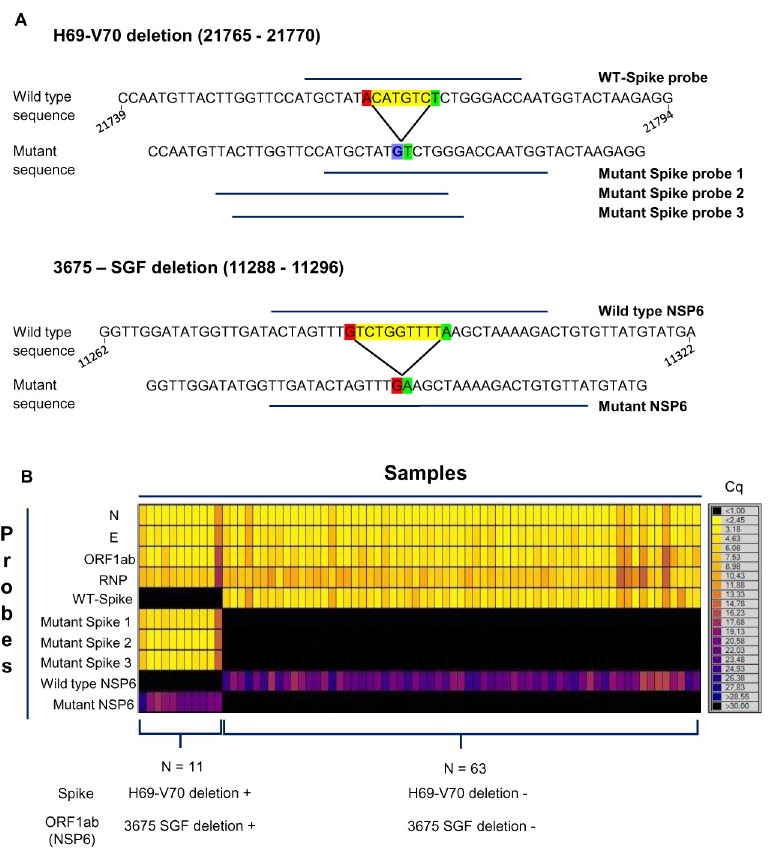
Fig 4. Use of the Biomark-based protocol to detect mutations associated with SARS-CoV-2 variants. (A) Overview of the probes design used for the detection of two deletion mutations found in the Spike gene (H69-V70, top panel) and in the NSP6 gene (3675-SGF, bottom panel). Deletions are highlighted in yellow with both nucleotide at the 5’ and 3’ side shown in red and green respectively. Of note: for the H69-V70 mutation an A-to-G punctual deletion is shown in blue. Three mutant probes and one wild type probe were generated for the H69—V70 deletion (21765–21770) and one mutant and one wild type probes were generated for the 3675 –GSF deletion (11288–11296). The nucleotide numbering is based on the reference SARS-CoV-2 complete sequence (NCBI Reference Sequence: NC_045512.2). (B) Heatmap of Cq value from RT-qPCR using various combinations of primer/probes performed on 74 SARS-CoV-2 positive clinical samples. Cq scale range is shown on the right. Using the Biomark-based protocol, 11 positive samples for the mutation associated with the SARS-CoV-2 variants have been detected (on 74 positive clinical samples).